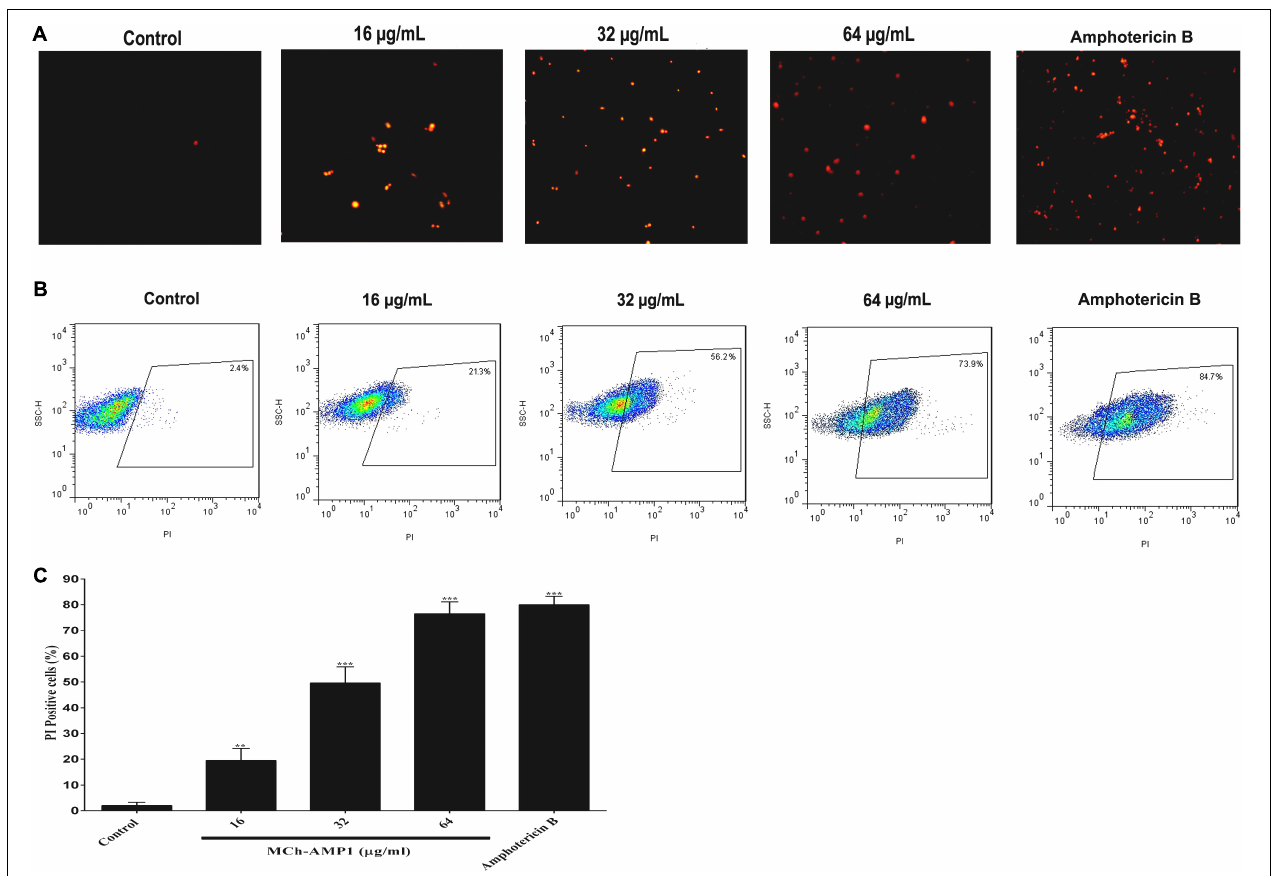
FIGURE 2 | Effect of MCh-AMP1 on the cell membrane permeability of C. albicans ATCC 10231, measured by PI uptake. (A) Fluorescence microscopy analysis of membrane permeabilization assay by PI uptake. (B) Flow cytometric analysis of membrane permeabilization assay by PI uptake. Approximately 1 × 10 6 cells/mL cells were incubated with MCh-AMP1 (16–64 µ g/mL) and amphotericin B (2 µ g/mL) for 3 h. (C) Histogram analysis shows the percentage of PI-positive C. albicans cells. Data are presented as the means ± SD of three independent experiments. The results are based on three independent experiments and represent the average, standard deviation, and P -values (** p ≤ 0.01, *** p ≤ 0.001) denote statistically significant differences from the effect of MCh-AMP1 on the control cells.